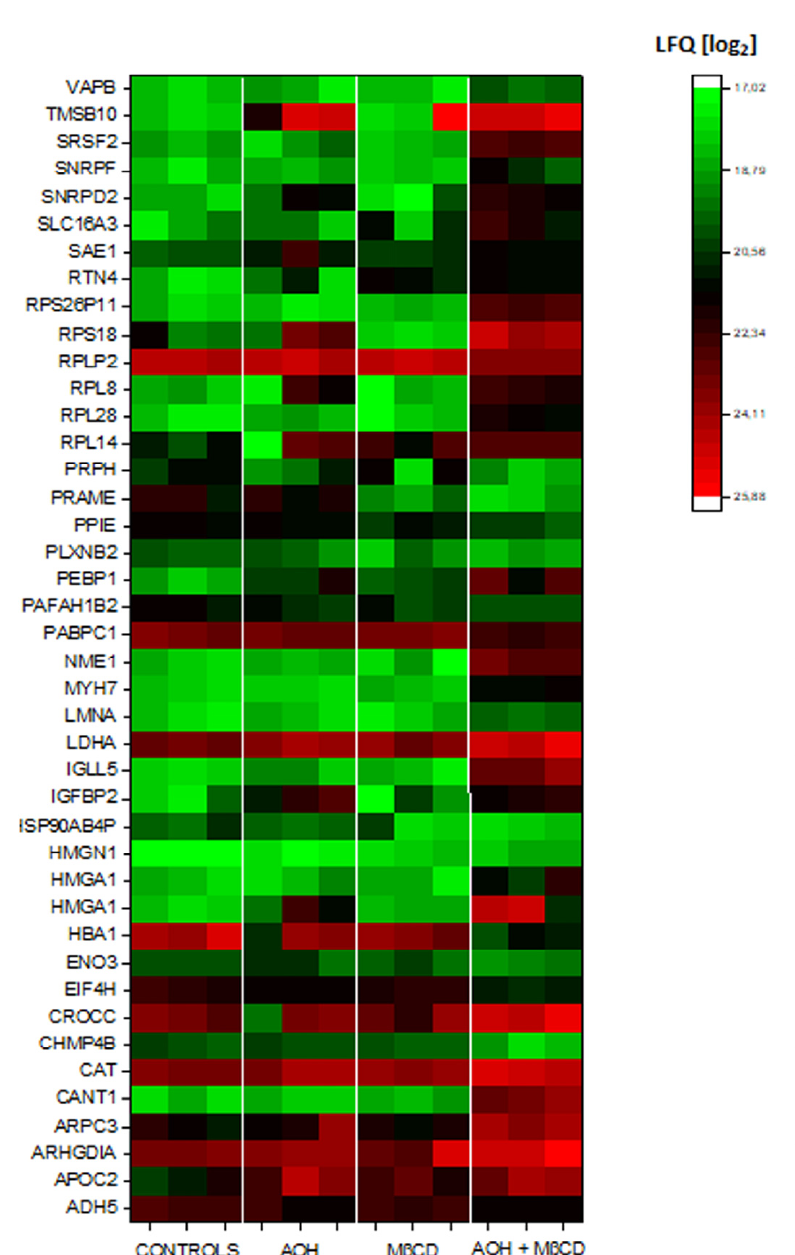
Figure 4. Secretome analysis of THP-1 macrophages incubated with AOH (1 µ M) and / or M β CD (50 µ M) for 5 h. Heat map depict the 3 biological replicates performed for each treatment group and includes all the proteins significantly regulated by the combination of 1 µ M AOH + 50 µ M M β CD. Single treatment (1 µ M AOH or 50 µ M M β CD alone) induced no significant regulation in comparison to controls. Green to Red colors depict the variation of the LFQ intensities [log 2